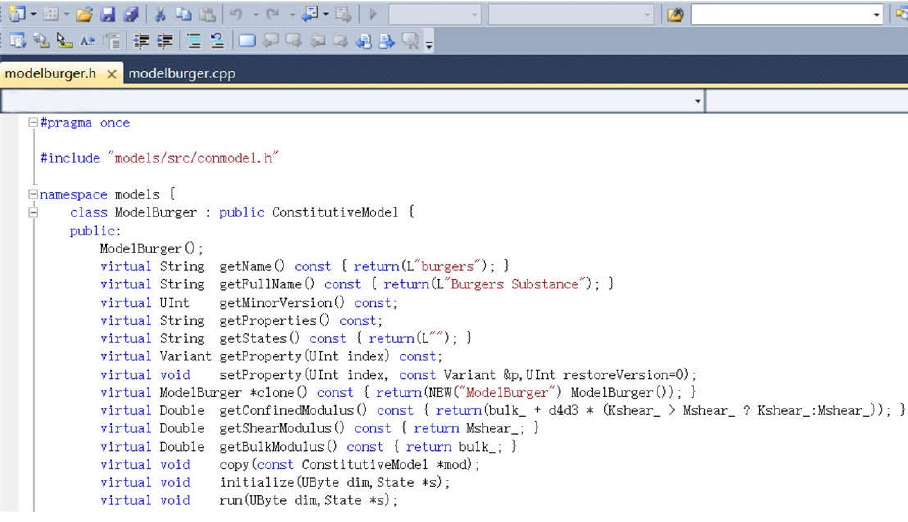
Figure 4. Code editing window.